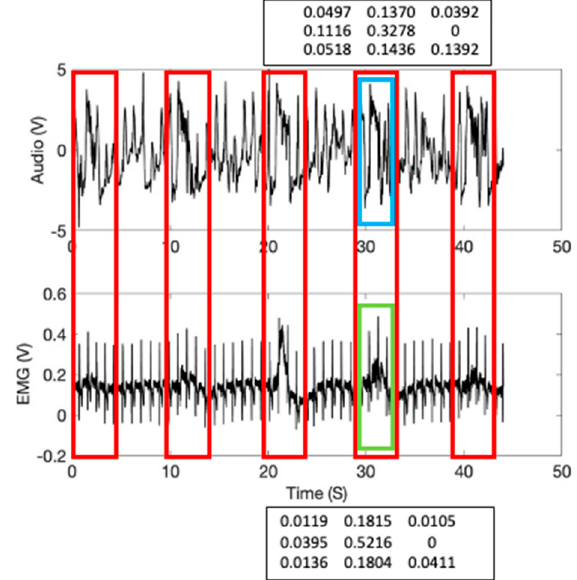
Figure 9 . The signature matrix’s data windows in the sensor signals at EIM location (1000 mL tidal volume): Sound template window (inspiration; shown in a blue box); EMG template window (shown in a green box) .